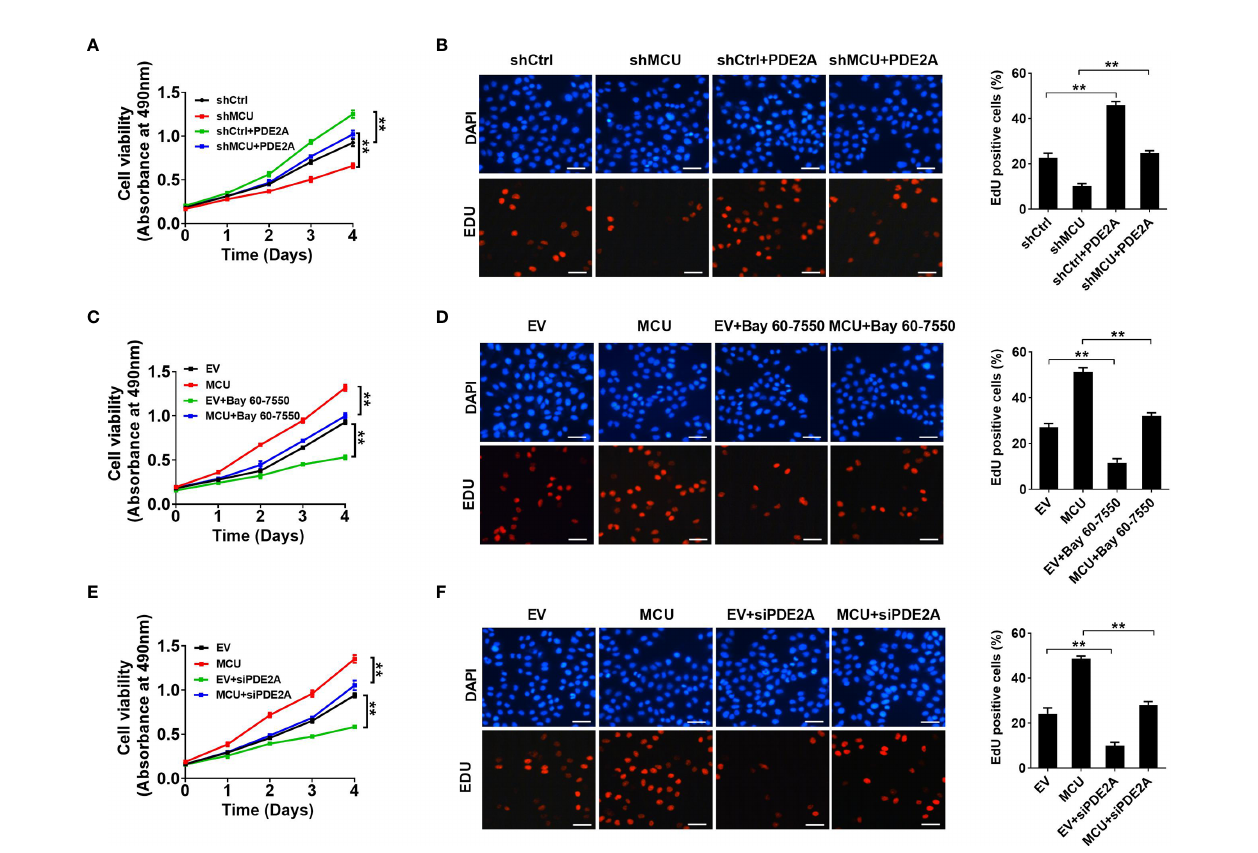
FIGURE 3 | Activation of PDE2 is essential for mitochondrial Ca2+-mediated CRC cell proliferation in vitro . (A, C, E) MTS assay for cell viability and (B, D, F) EdU incorporation assays for cell proliferation in LS174T cells with treatments as indicated (scale bar, 20 m m). PDE2A, expression vector encoding PDE2A; siPDE2A, siRNA against PDE2A. **P <